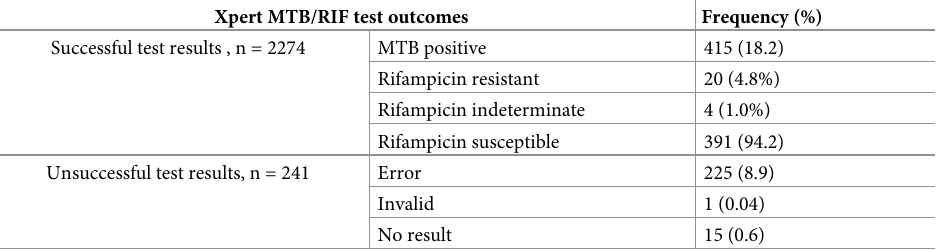
Table 3. Xpert MTB/RIF results at National TB Reference Laboratory of Ethiopia, January 2018 –December 2018, N =